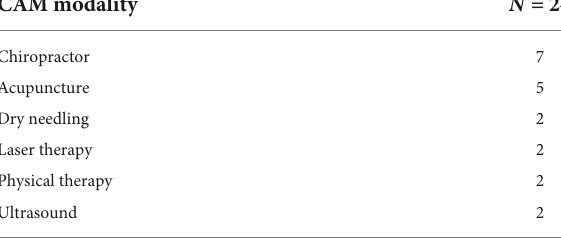
TABLE 6 Qualitative reporting of least useful complementary and alternative medical (CAM)